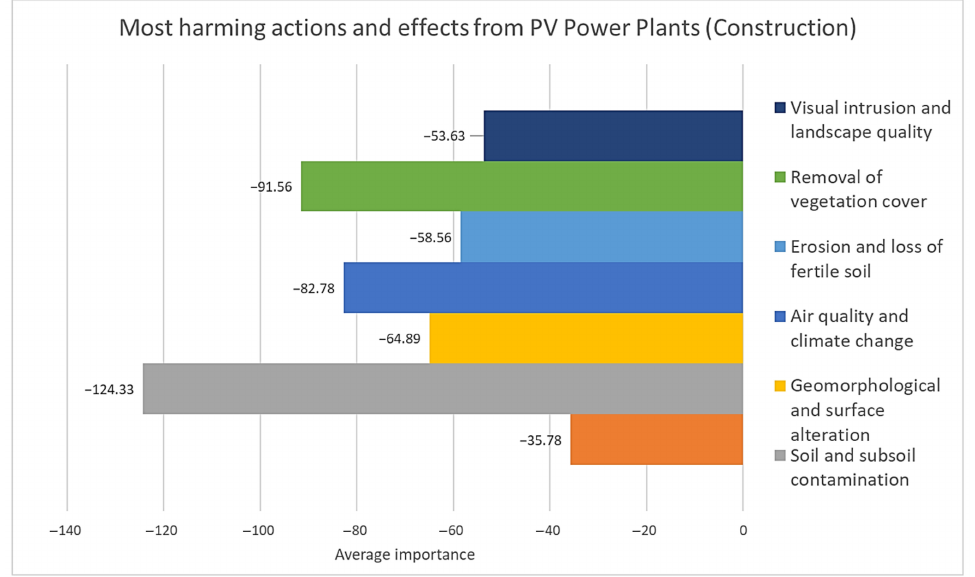
Figure 9. Average importance values of the most harming actions during installation of PV centrals. Performing the same evaluation for the years of operation of the different plants, the following actions were determined as the most relevant. Values lower than 25 are consid- ered compatible or not significant; therefore, Figure 10 only shows the moderate values or those with a significant impact on the natural environment during operation that cannot be avoided after preventive and corrective measures. In addition, the positive impacts that exist after the start-up of the PV plant are observed, such as: energy resources, economic the impact of avoided emissions that contribute to air quality and climate change.